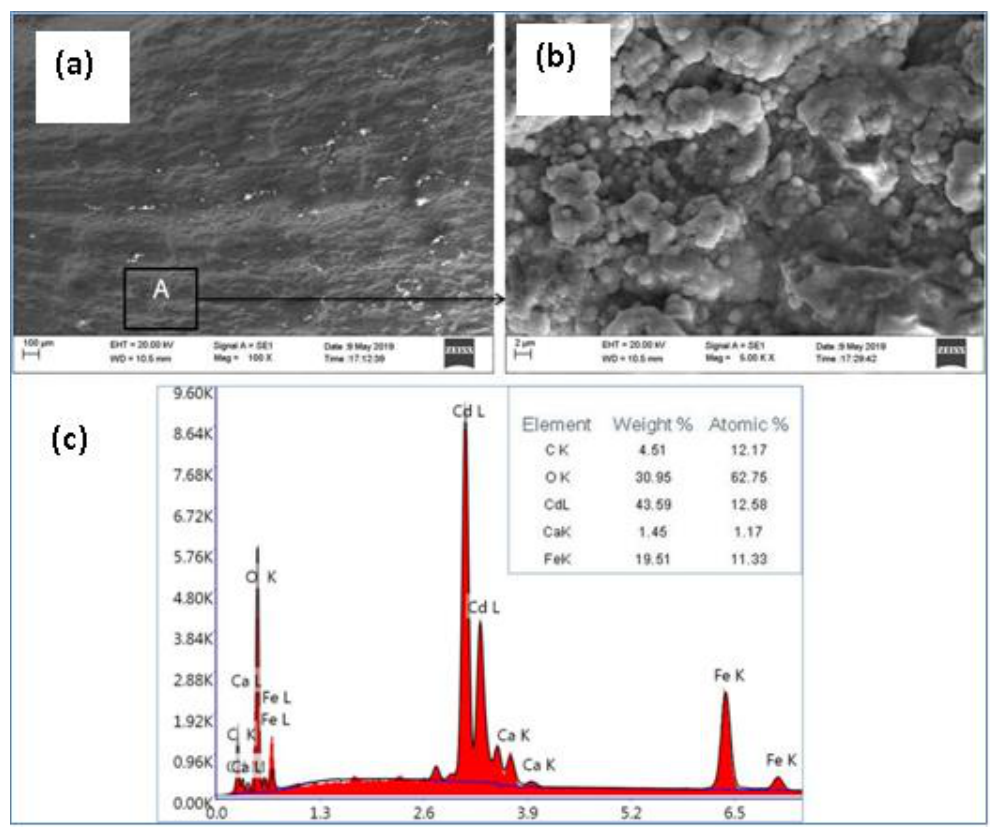
Fig. 6: High magnification images of region C (in Fig. 5a) showing presence of tiny cadmium particles, (b) high magnification image of the region A (marked in (a)) and (c) EDS pattern taken from tiny particles.